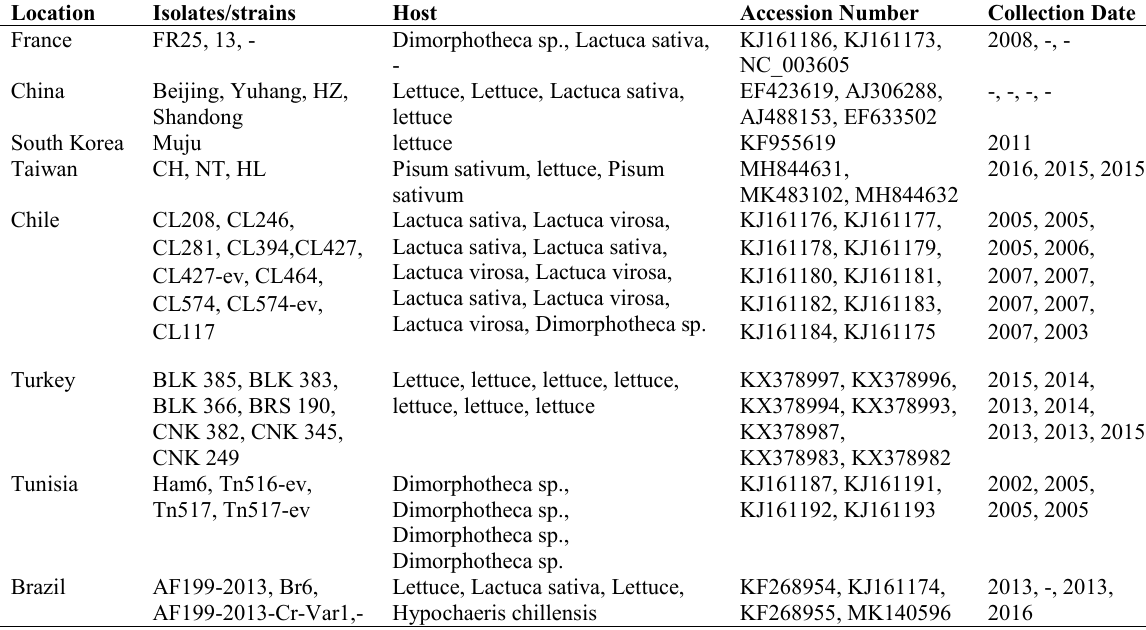
Table 1. List of the origins, hosts, and accession numbers of LMV isolates/strains. Location